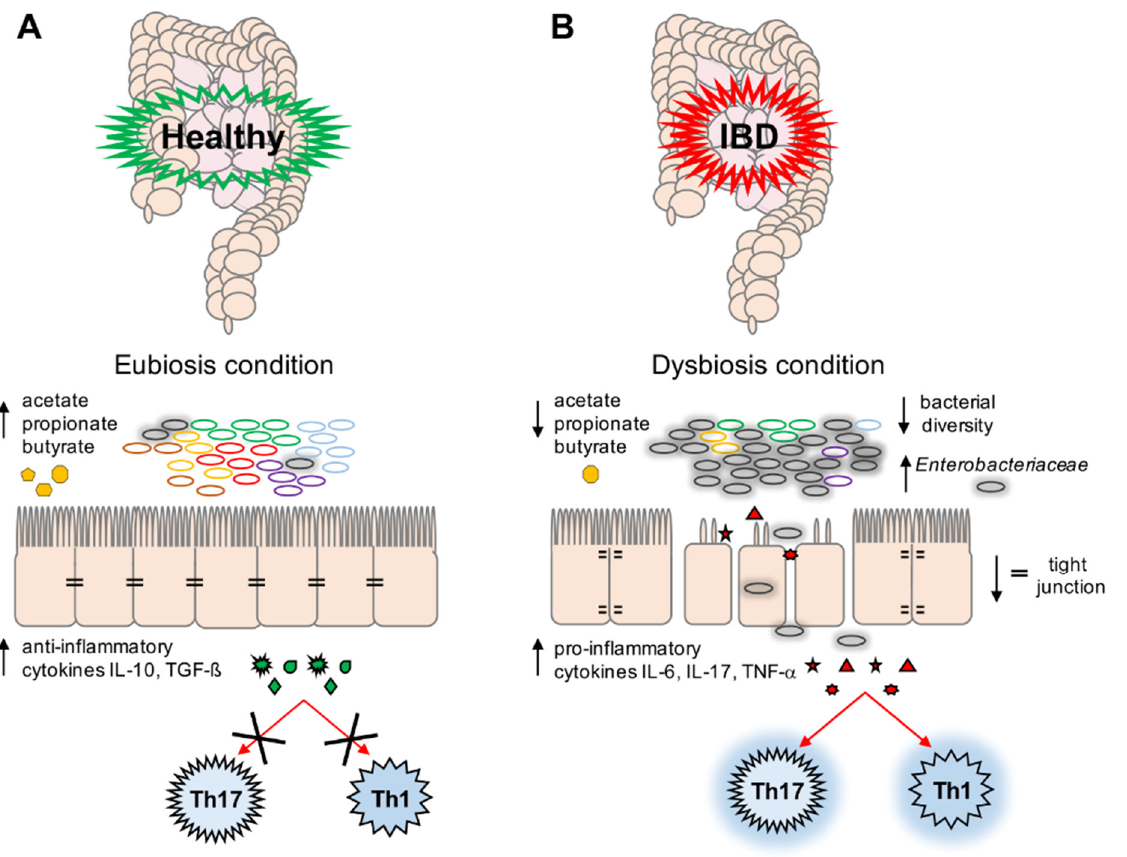
Figure 1. A schematic representation of eubiosis ( A ) and dysbiosis ( B ) conditions. ( A ) Microbiota plays an important role in the maintenance of gut stability by: ( i ) producing short-chain fatty acids (SCFAs) (i.e., acetate, propionate, and butyrate), ( ii ) preventing the expansion in any microbial pathogens, and ( iii ) modulating the immune system (i.e., production of anti-inflammatory cytokines (Interleukin (IL)-10, Transforming Growth Factor (TGF)- β )) and decreasing the activation of T-helper cell (Th)17 and Th1 cells; ( B ) During dysbiotic conditions, bacteria belonging to the Enterobacteriaceae family could overgrow, leading to a decrease in bacterial diversity and in gut stability. This is reflected by a decrease in SCFA production, and a parallel increase in pro-inflammatory cytokines such as IL-6, IL-17, and tumor necrosis factor (TNF)- α , which activate Th17 and Th1 cells involved in the inflammation response. Moreover, a decrease in tight junctions and a subsequent loss of impermeability in the intestinal epithelium is observed.